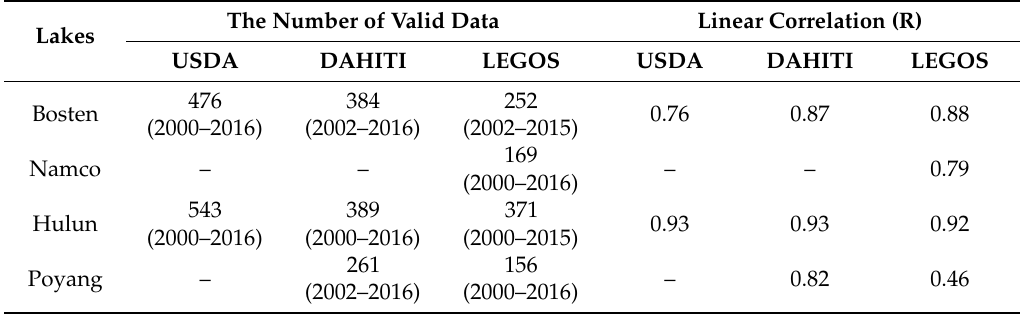
Table2. Thenumberofaltimetrydataobtainedandcorrelationcoe ffi cientscorrespondingtowaterareas.